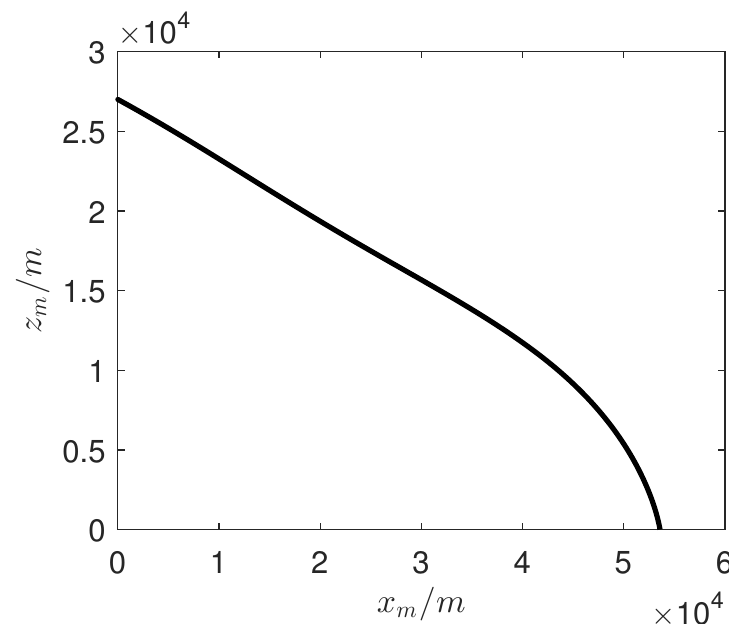
Figure 4. Curve of trajectory on the x and z axes.